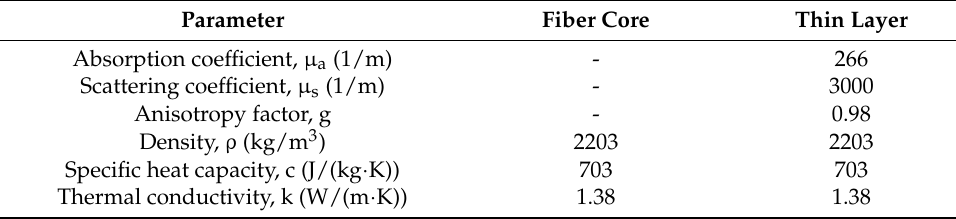
Table 2. Characteristic parameters of optical fibers [32].